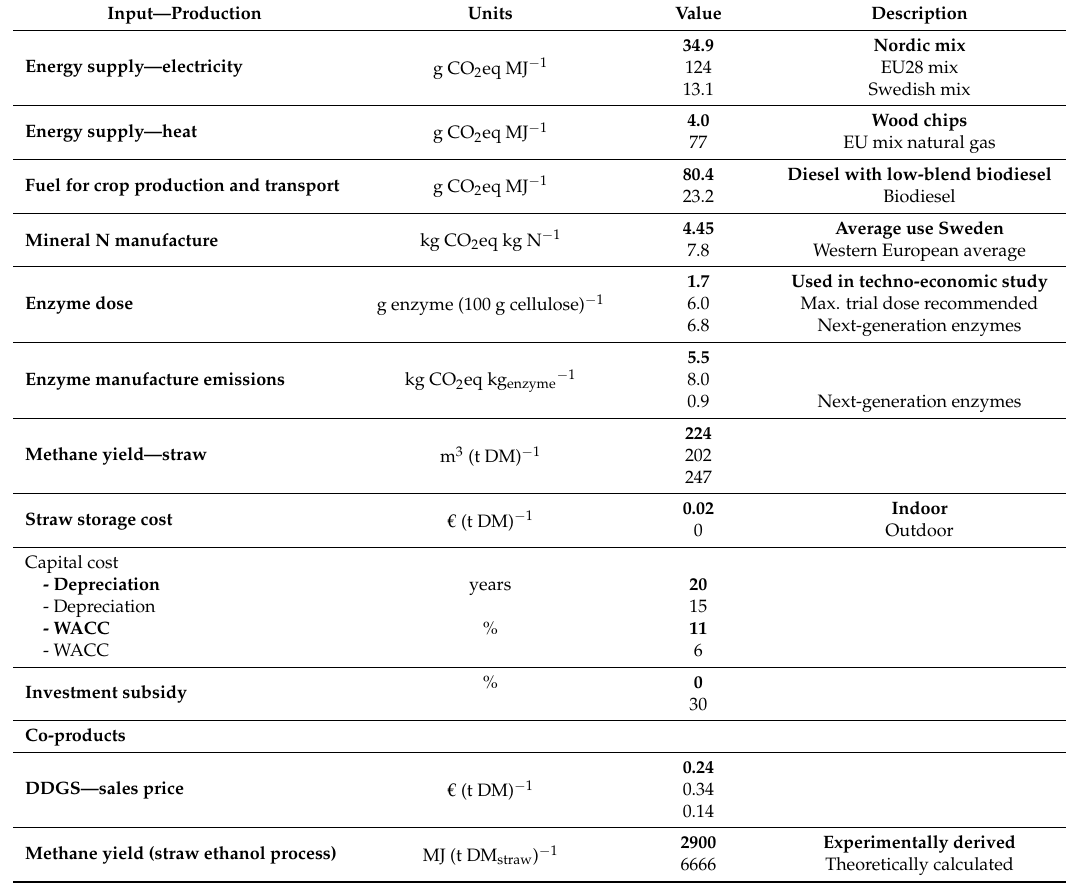
Table 5. Values evaluated in the base case (bold) and alternative values (Further information on the selected emission values and references can be found in Appendixs B and